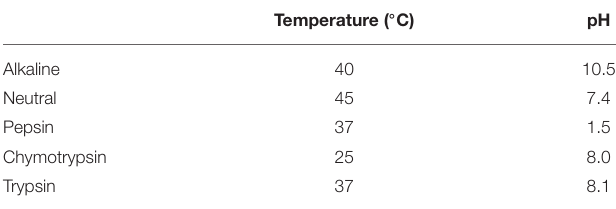
TABLE 1 | Optimal hydrolysis conditions.